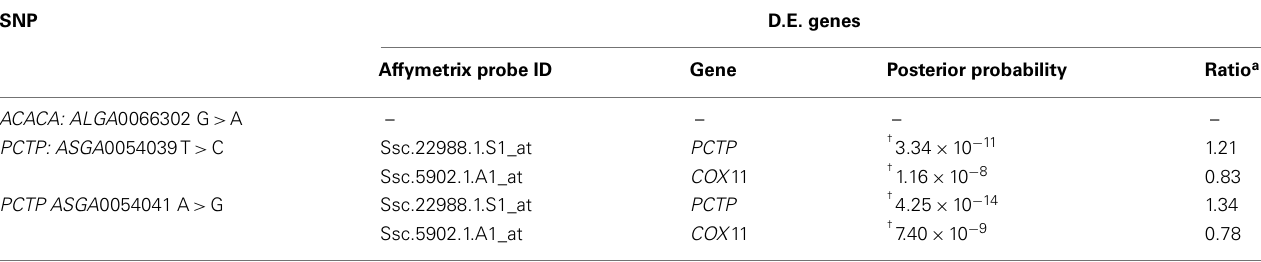
a Effect on expression of the SD of the SNP allele copy number in the untransformed scale; σ = 0.51 for ASGA0054039 T > C and σ = 0.66 for ASGA0054041 A > G † FDR <